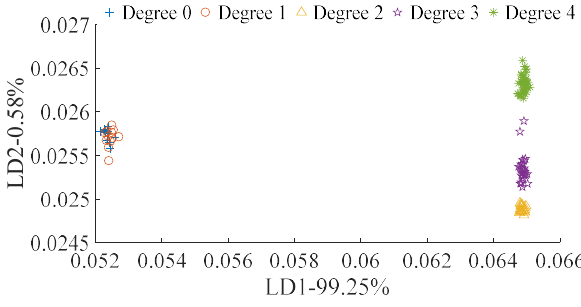
Figure 6. LDA granulation degree classification based on the spectral raw